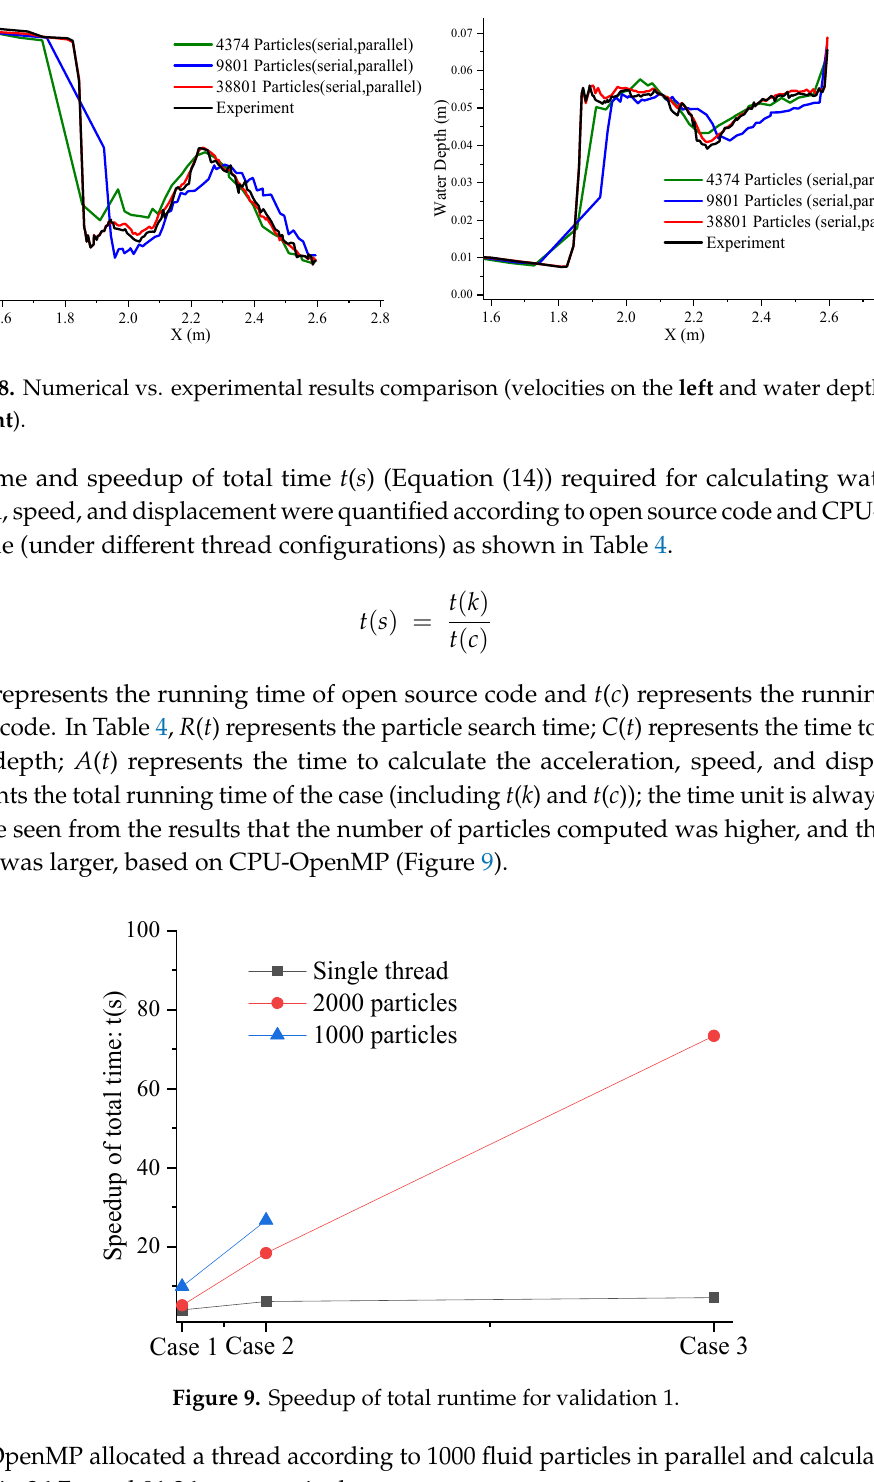
Figure 9. Speedup of total runtime for validation 1.